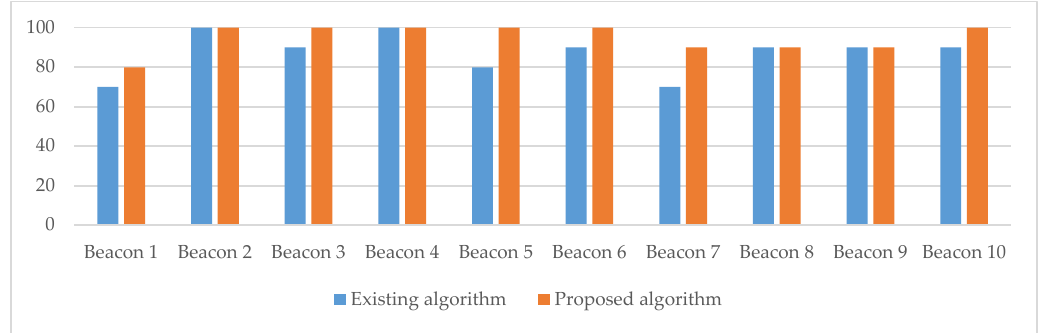
Figure 17. The success rate of correct transmitter detections at the Expo Museum, Postojna. Table 7. Comparison of overall success rates of both algorithms. Existing algorithm Improved Algorithm Level of improvement